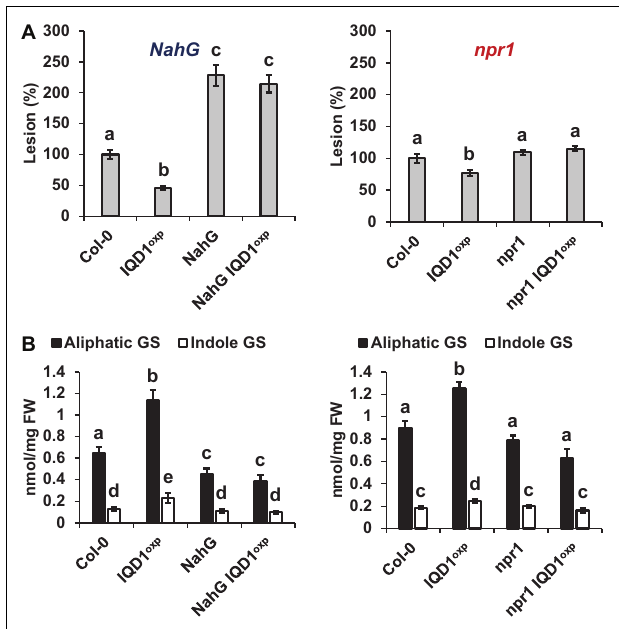
FIGURE 4 | IQD1 OXP affects SA pathway mutants. (A) Detached leaves from 6 week-old Arabidopsis SA pathway mutants were inoculated with B. cinerea . Lesion sizes were measured 72 h post-inoculation. Average lesion sizes from 30 leaves of each line are presented, along with the standard error of each average. All numbers are presented as the relative percentage to the corresponding background wild-type. Different letters above the columns indicate statistically significant differences at P < 0.05, as determined using the Tukey’s honest significant difference test. (B) Glucosinolates were extracted from 6-week old Arabidopsis seedlings of SA pathway mutants and analyzed by HPLC. Mean contents of methionine-derived (black bars) and tryptophan-derived (gray bars) glucosinolates are given for each line. Each column represents an average of eight seedlings, with standard error bars indicated. Different letters above the columns indicate statistically significant differences at P < 0.05, as determined using Tukey’s honest significant difference test. Results shown are from a biological replicate representative of three independent